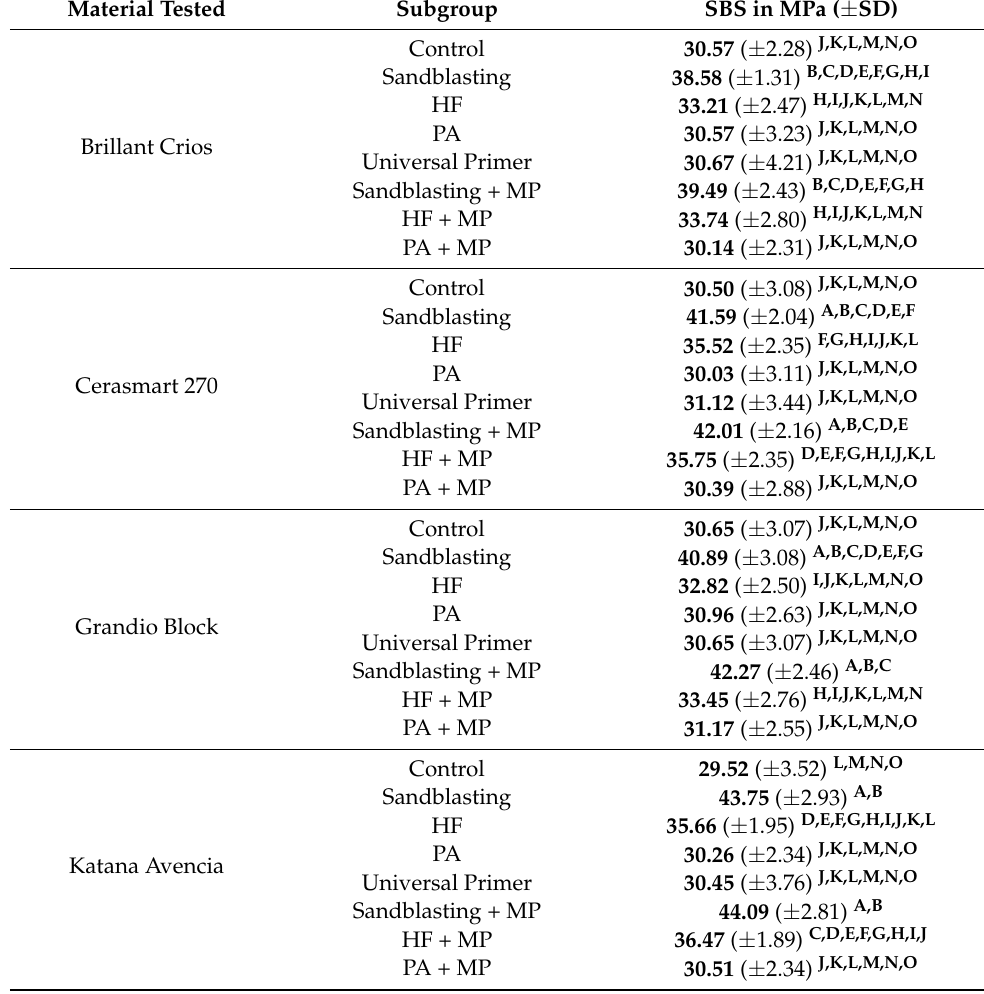
Table 3. Mean and standard deviations of shear bond strength (SBS) after micromechanical, chemical and combination of micromechanical and chemical surface